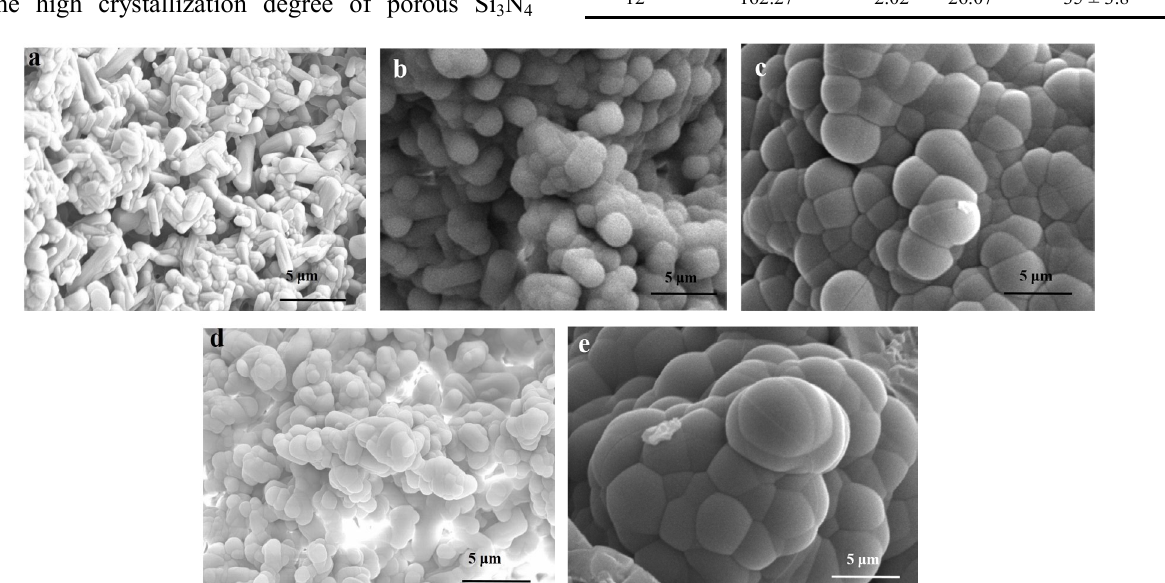
Fig. 3 Micrographs of porous Si 3 N 4 –Si 3 N 4 composite ceramics as a function of deposition time: (a) 0, (b) 3, (c) 6, (d) 9, and (e)12